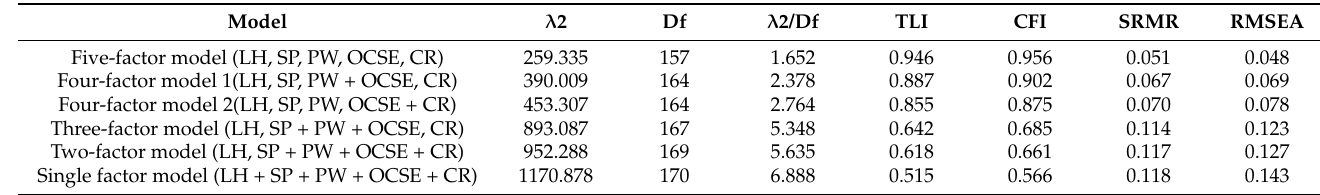
Table 1. Confirmatory Factor Analysis Test Results of Variables (N = 351).